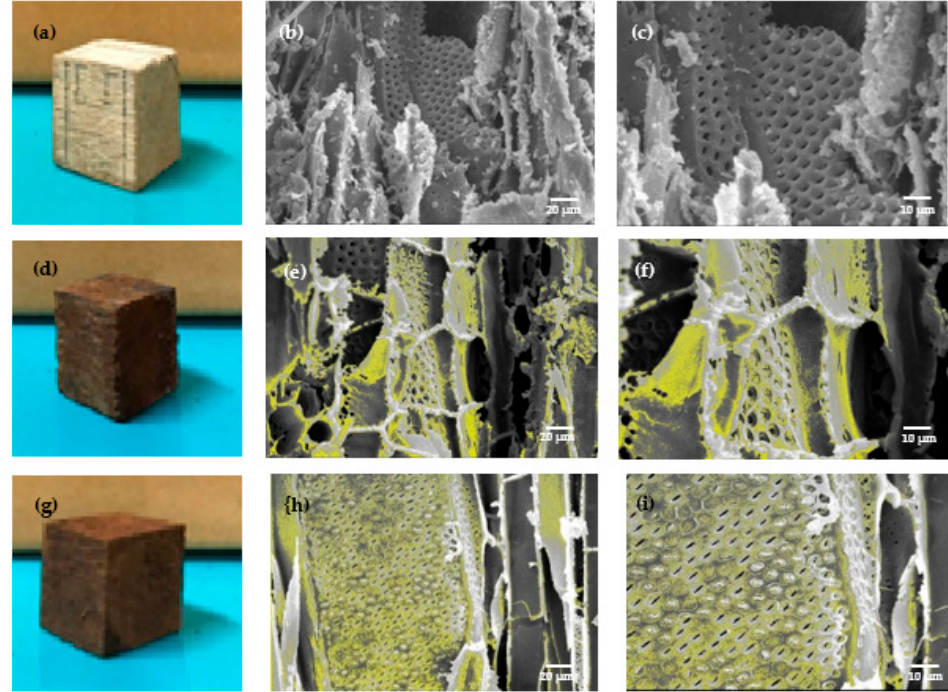
Figure 2. ( a ) Untreated jabon wood; ( b ) tangential section of untreated jabon wood at ×550 magnifi- cation; ( c ) tangential section of untreated jabon wood at ×1000 magnification; ( d ) magnetic jabon wood after in-situ treatment with NaOH precursor; ( e ) tangential section of magnetic jabon wood after in-situ treatment with NaOH at ×550 magnification; ( f ) tangential section of magnetic jabon wood after in-situ treatment with NaOH at ×1000 magnification; ( g ) magnetic jabon wood after in-situ treatment with NH 4 OH; ( h ) tangential section of magnetic jabon wood after in-situ treatment with NH 4 OH at ×550 magnification, and ( i ) tangential section of magnetic jabon wood after in-situ treatment with NH 4 OH at ×1000 magnification.